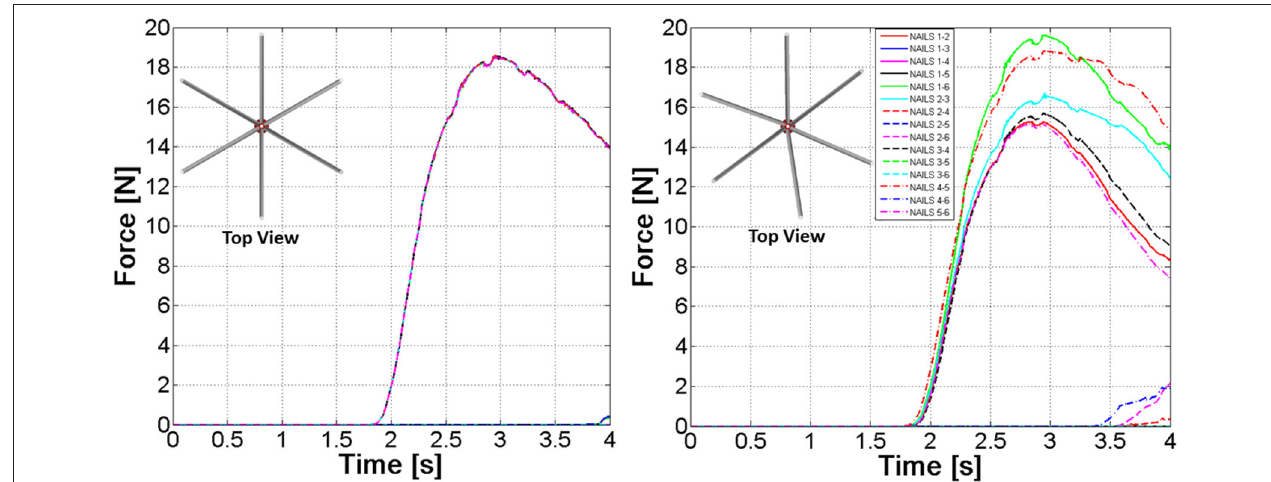
FIGURE 13 | Nail-to-nail contact forces. “Ideal” device (Left) —“Realistic” device (Right) .